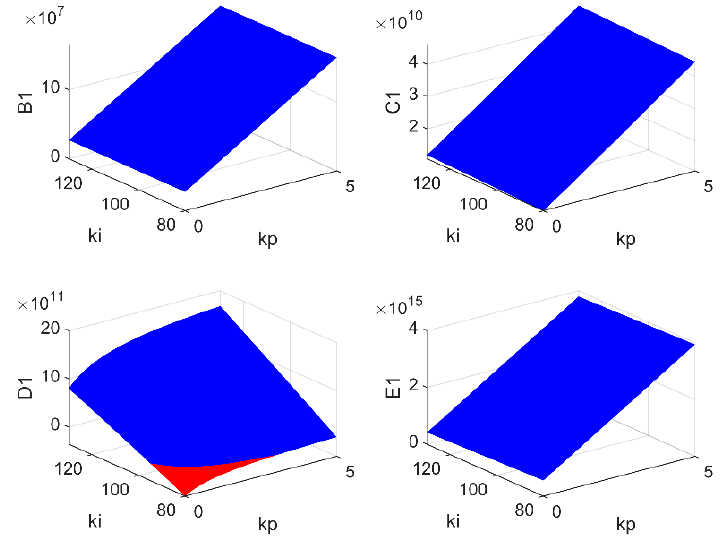
Figure 8. Three-dimensional diagram of B 1 , C 1 , D 1 and E 1 with variation of PI parameters.